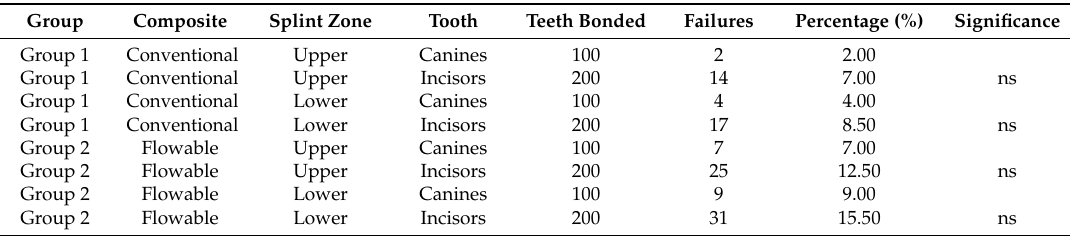
Table 5. Numbers and failure rates of fixed retainers for upper and lower teeth in the two groups tested, distinguishing canines and